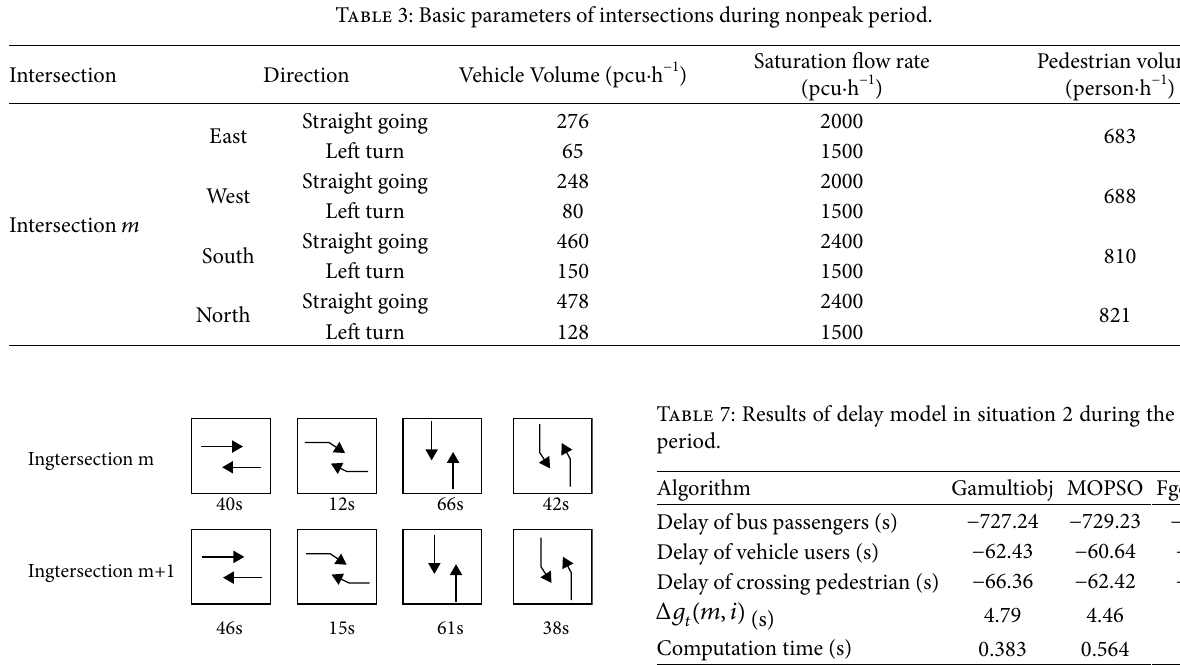
Figure 10: Coordinated control timing scheme. Table 4: Results of delay model in situation 1 during the peak period.